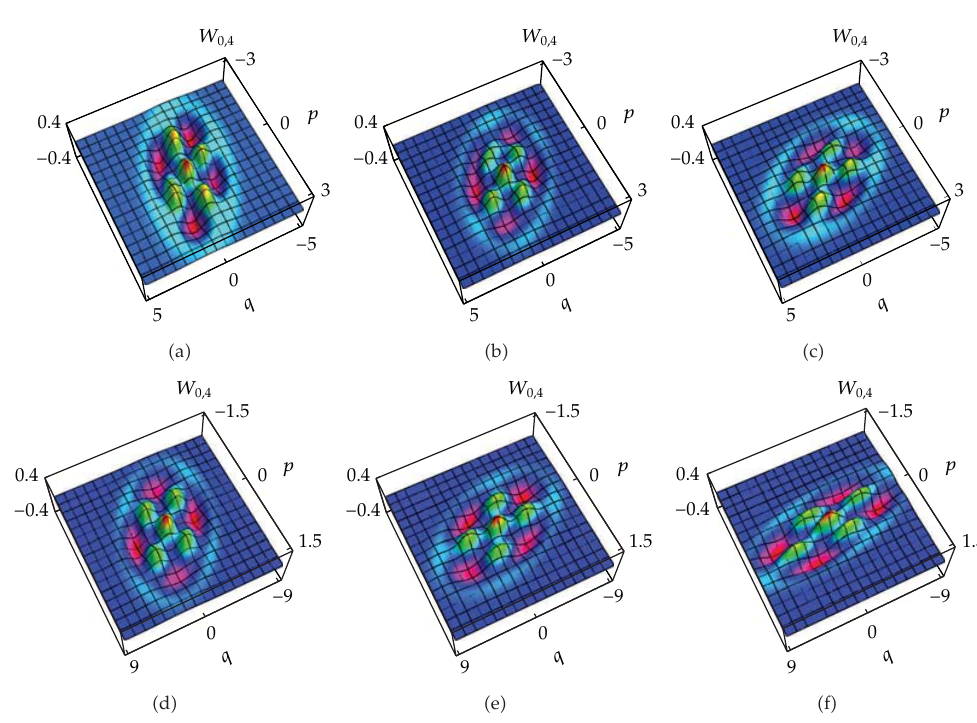
√ 2 (cid:5)(cid:4) | 0 (cid:4) (cid:9) | 4 (cid:4) (cid:5) at successive times; δ 0 (cid:8) 0 .